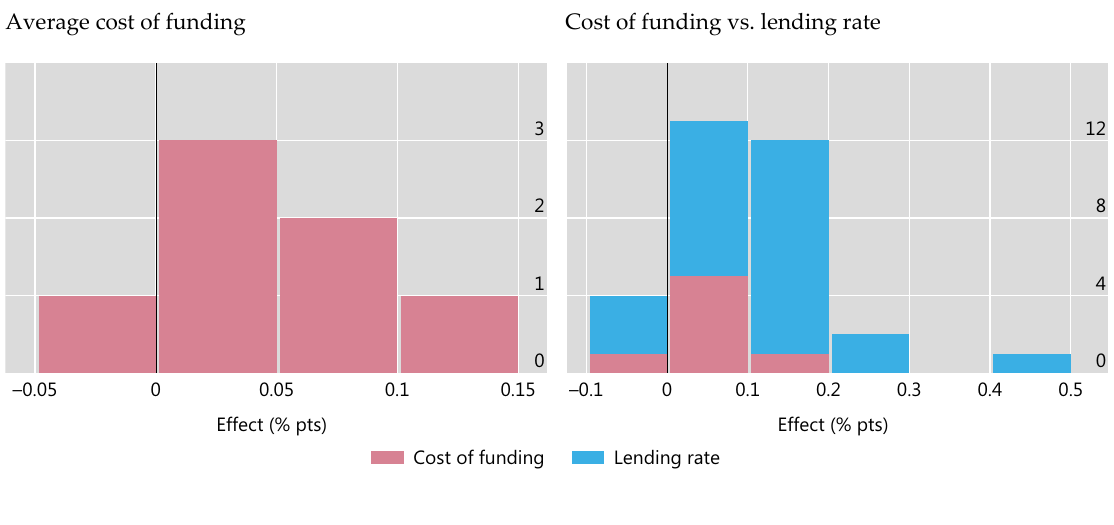
Figure 4. Effect of a one percentage point higher capital ratio on banks’ cost of funding and lending rate. Based on six RTF survey responses and 25 estimates from 17 studies (see references Almenberg et al. (2017), Baker and Wurgler (2013), Barth and Miller (2018), BCBS (2010), Benetton et al. (2017), Brooke et al. (2015), Cosimano and Hakura (2011), Dagher et al. (2016), Firestone et al. (2017), Gambacorta and Shin (2018), Glancy and Kurtzman (2018), Junge and Kugler (2013), Kashyap et al. (2010), Miles et al. (2013), Santos and Winton (2013), Slovik and Courn è de (2011), Sutorova and Tepl ý (2013)). Source: Financial Regulation Assessment: Meta Exercise, stats.bis.org/frame .